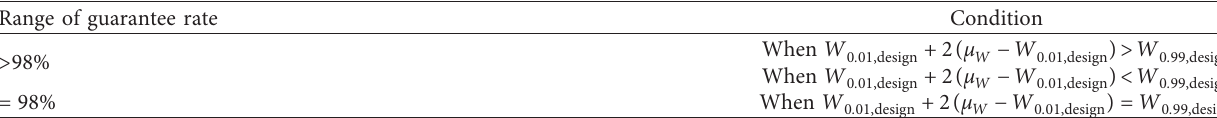
Table 3: Guarantee rate range